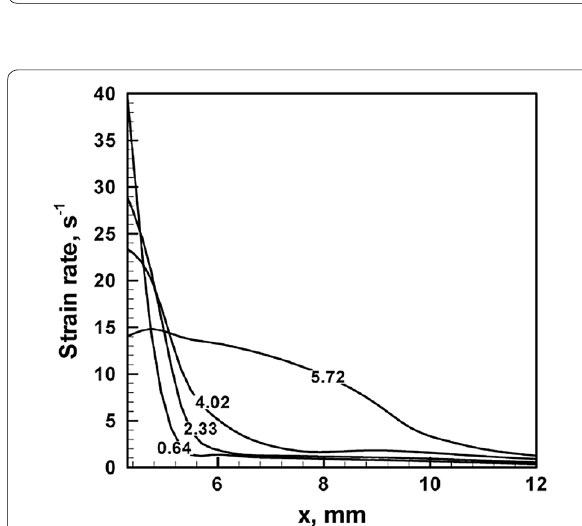
Figure 42 Relationship between the temperature and the strain rate [84]